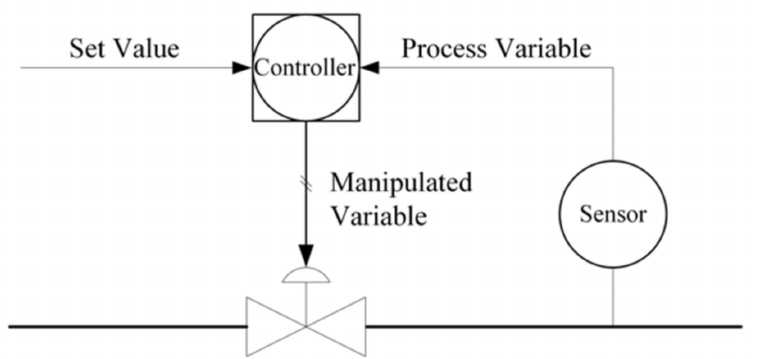
Figure 7. General configuration of a process variable, a manipulated variable, and a set